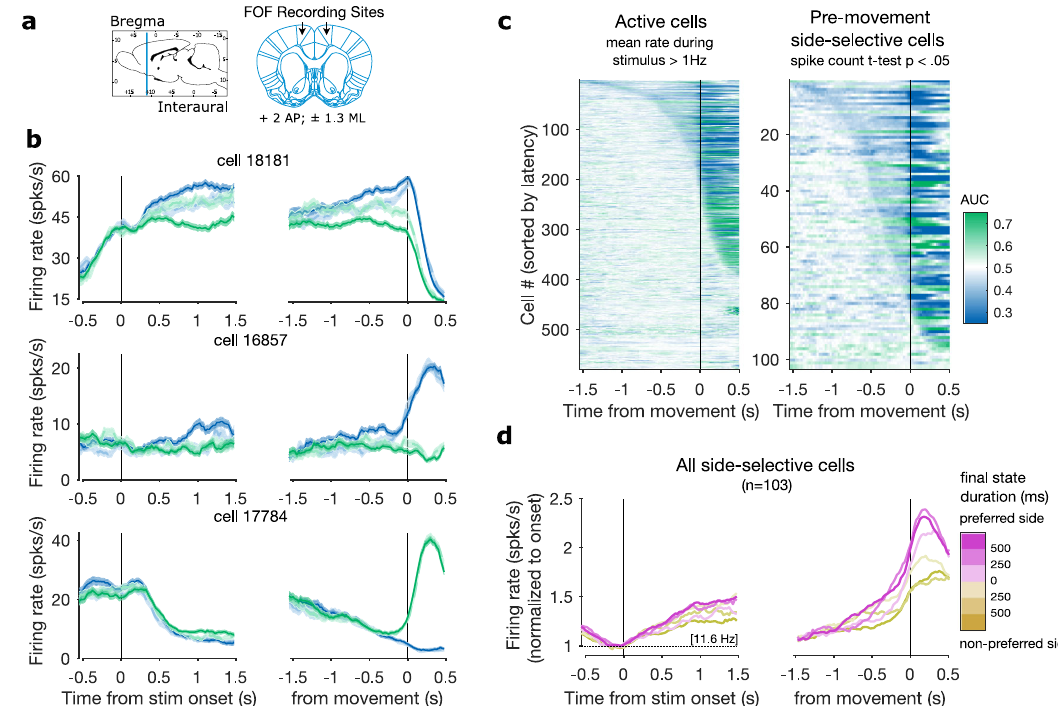
Fig. 2 FOF neurons encode the rat ’ s upcoming choice. a Coordinates used for FOF recordings ( + 2 AP; ± 1.3 ML). b Average fi ring rates for three example FOF cells aligned to stimulus onset (left) and movement (right). Activity is conditioned on right (green) vs. left (blue) side choice, as well as hits (solid lines) vs. errors (dashed lines). Shaded regions represent s.e.m. c Side-selectivity at each time point relative to movement for all active cells (left; fi ring rate > 1 Hz) and for the subset of these cells that meet the spike count pre-movement side-selectivity criterion (right; 2-tailed t test p < 0.05). AUC is computed on spike rates for right versus left choices. Plots are sorted by latency to 200 ms (8 consecutive time bins) of signi fi cant AUC values relative to a distribution created by permuting choice labels across trials (2-tailed permutation test, 250 permutations, p < 0.05). d Average activity of all pre- movement side-selective cells conditioned on fi nal state duration and cells' side preferences. Grand-average fi ring rate at stimulus onset (11.6 Hz) is written in brackets. Source data are provided as a Source Data fi